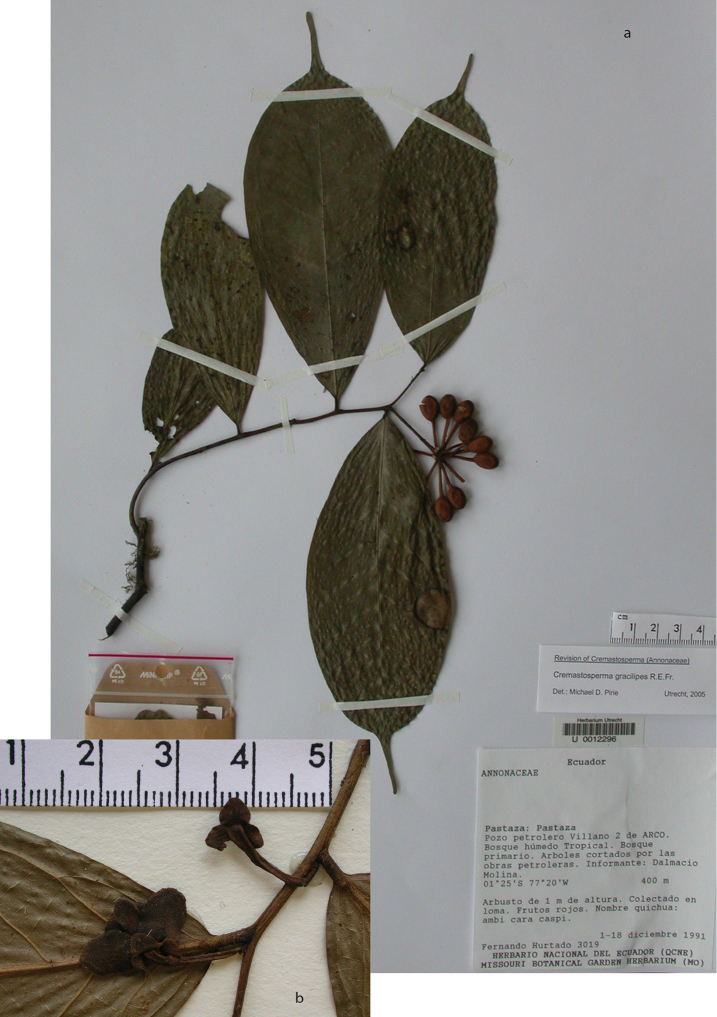
Cremastospermagracilipes R.E.Fr. a fruiting specimen b flower (aHurtado 3019bPalacios 1651).